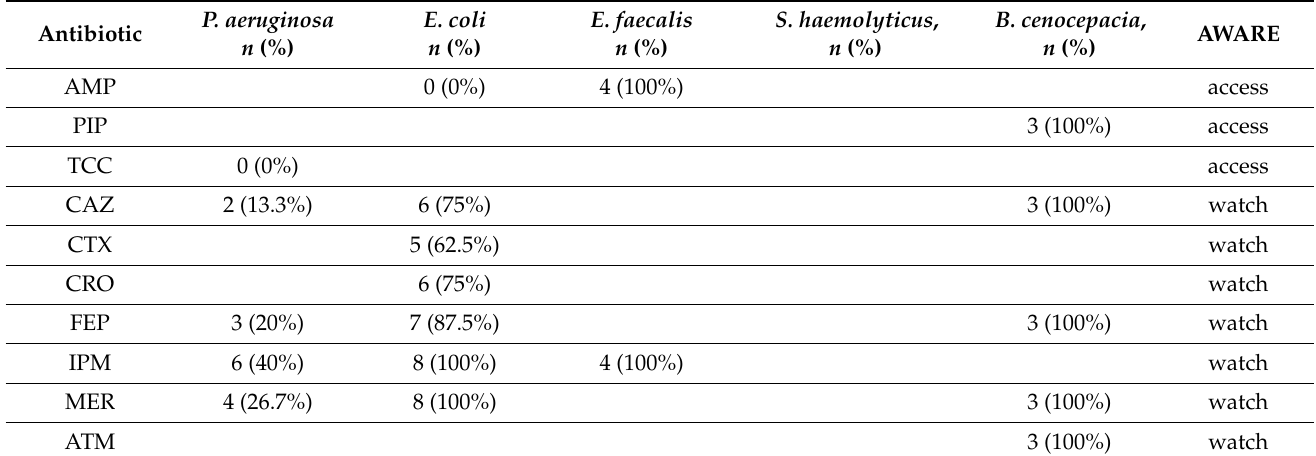
Table 3. Antibiotic sensitivity of the main strains of microorganisms isolated after